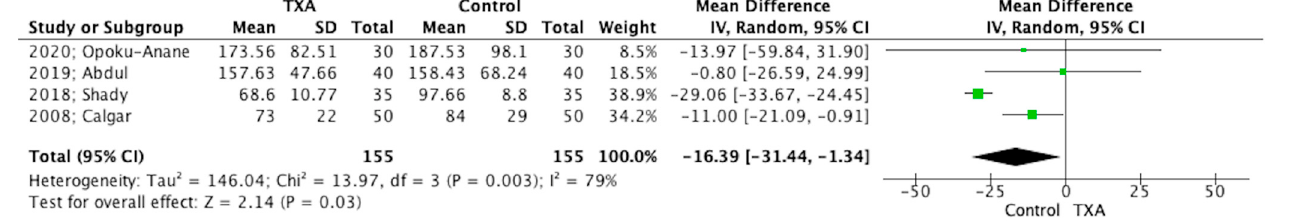
Figure 5. Forest plot depicting operative time [13–16]